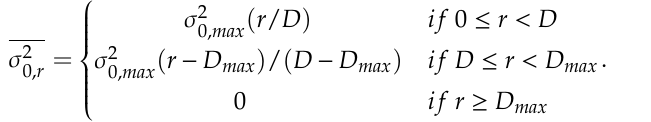
the total MSRD (blue) ( b